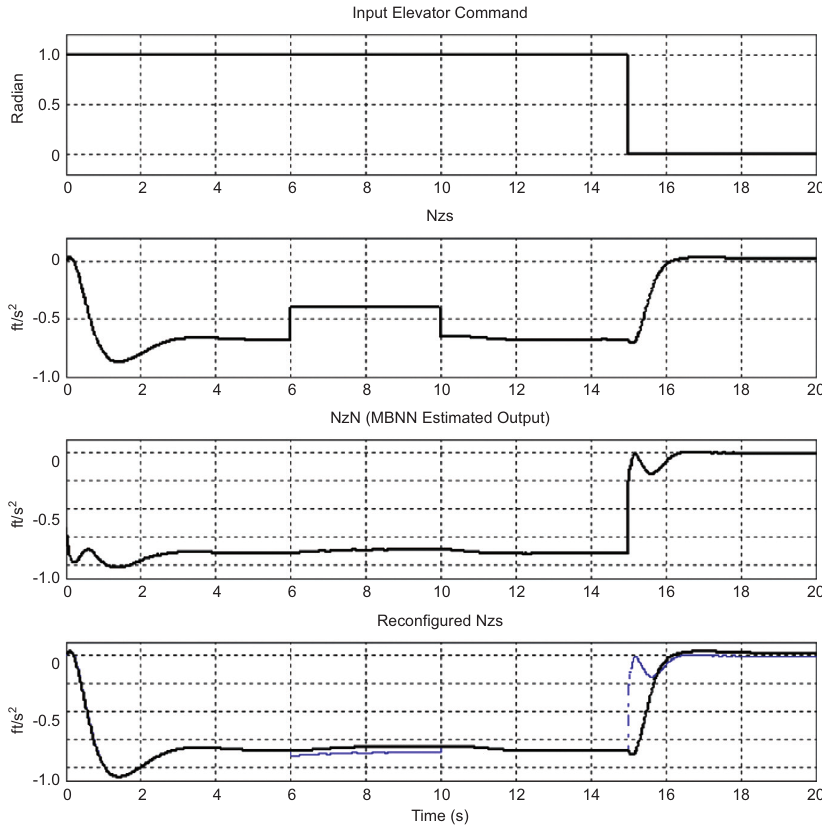
Figure 13. SFDA for Stuck Sensor Fault of “–0.4” from 6 to 10 s (Intermittent Fault).